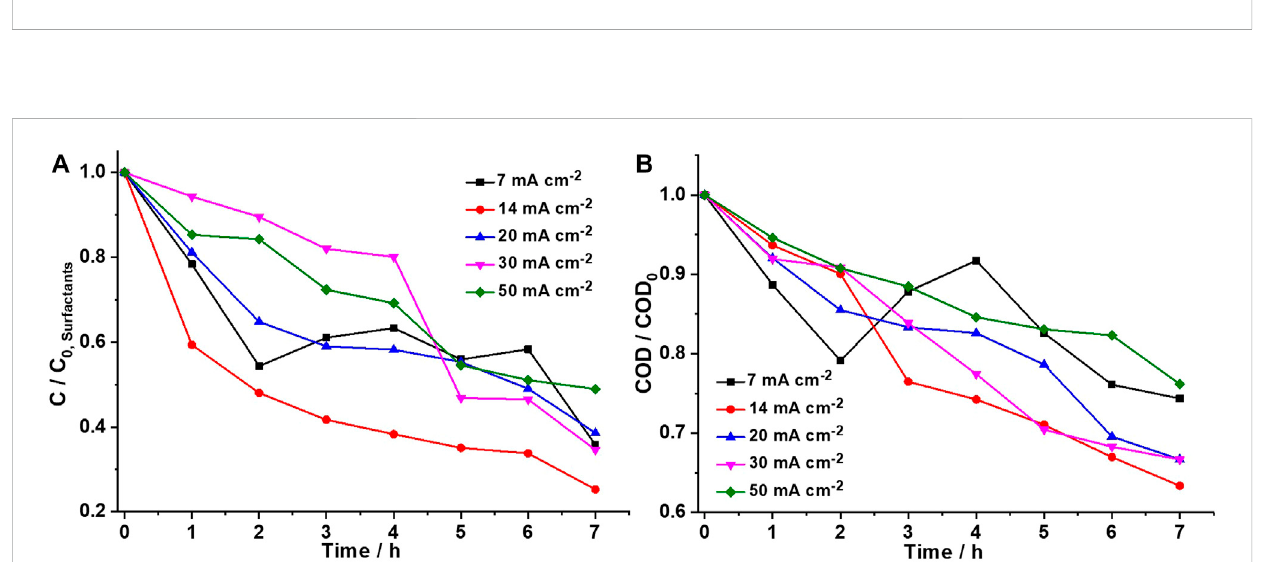
FIGURE 4 Effect of current density on domestic wastewater electroremediation through (A) surfactant concentration and (B) chemical organic demand at an optimal fl ow rate (1.5 L min − 1 ) using a DiaClean ® cell coupled with BDD as an anode and SS as a cathode.